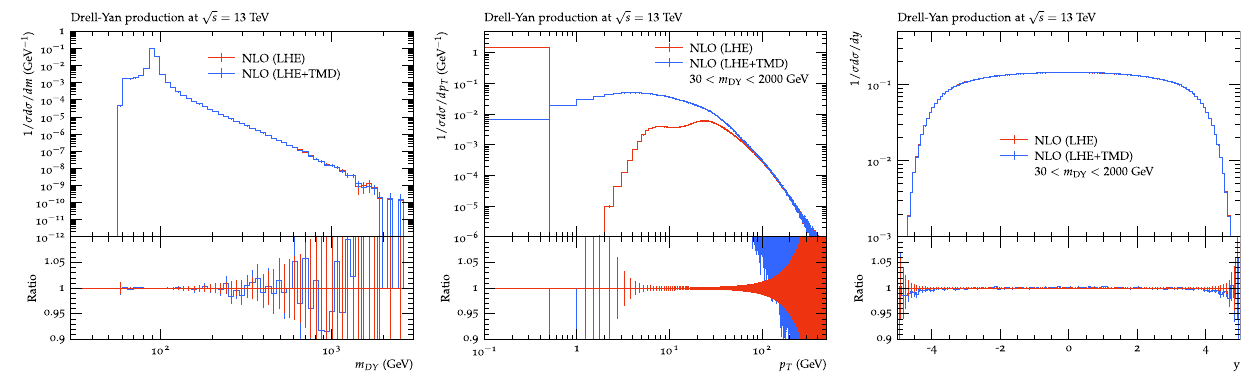
Fig. 1 Distributions of Drell-Yan mass, transverse momentum and tionincludingsubtractionterms,NLO(LHE+TMD)includestransverse √ s = 13 TeV. The hard process is rapidity for pp → DY + X at momenta of the interacting partons according to the description in the calculated with MadGraph5 _a mc@nlo . NLO(LHE) is the predic-